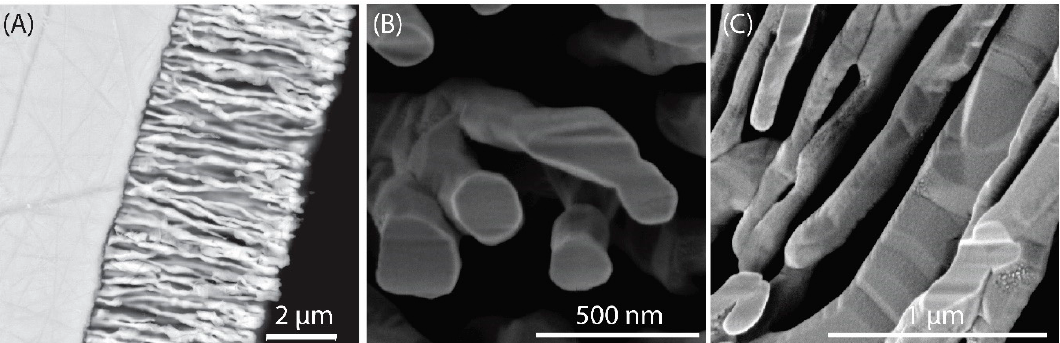
Figure 6. ( A ) Back-scattered electron image of cross section of partially-reacted calaverite showing the phase boundary between the porous gold product and the parent calaverite (solid grain). High-magnification images of gold showing three-dimensional structure of gold filaments, which were cut perpendicular ( B ) and parallel ( C ) to the long axis of the gold filaments.